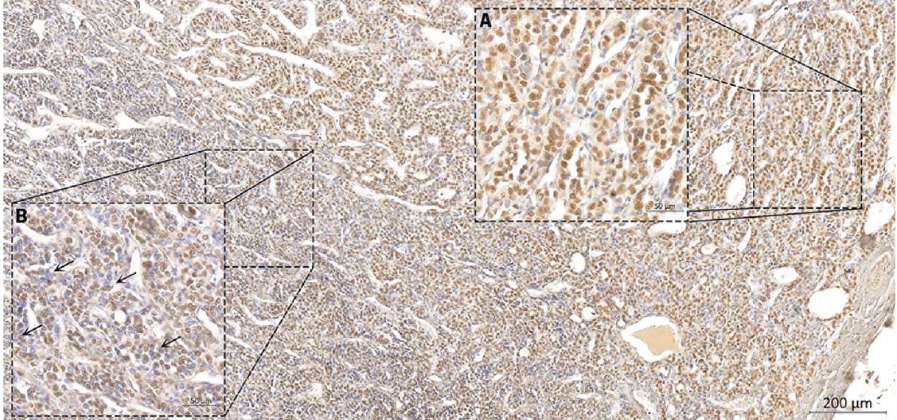
Figure 3. DGCR8 expression in the PDTC case with p.(E518K) mutation: ( A ) Overexpression of DGCR8 protein, with the highest expression in the series; ( B ) Some areas presented extensive loss of expression in some nuclei (black arrows) that putatively could be attributed due to LOH (as previously described in cases with p.(E518K) mutation).